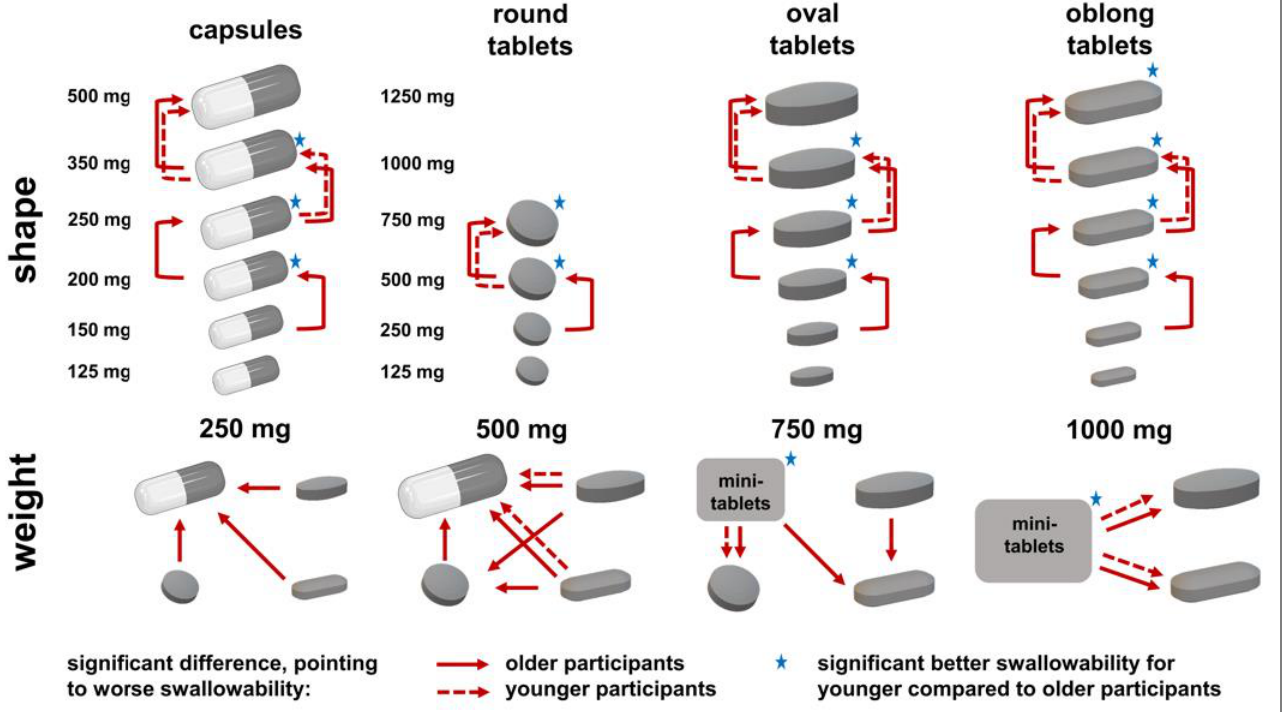
Figure 7. Significant differences according to the McNemar test for the data of visual perception. Arrows point to dosage forms showing a worse rating in terms of the anticipated swallowability. Results for the older participants (continuous line) and younger participants (dashed line) are shown. Comparisons between the dosage forms of the same kind were calculated for adjacent weights. For dosage forms of the same weight, all dosage forms were compared to each other. Stars indicate a significant difference between age categories according to Fisher’s exact test, implying better anticipated swallowability ratings for younger compared to older participants. To account for multiple testing, all calculated p -values were corrected according to Benjamini and Hochberg. p -values of <0.05 were deemed as significant.